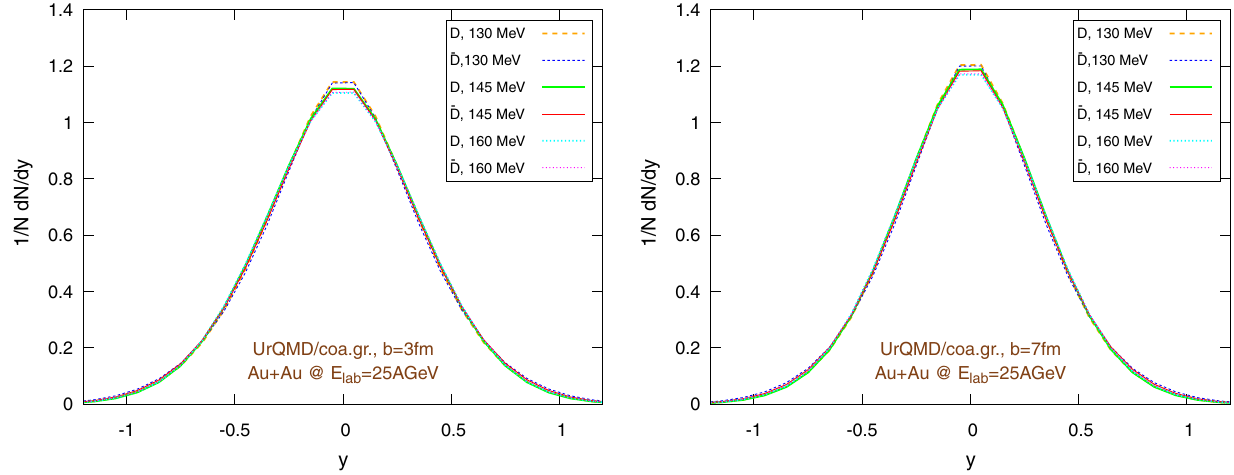
Fig. 13 Final 1 / N d N / d y distribution using the UrQMD/coarse-graining approach for Au+Au collisions at 25 GeV per nucleon in the lab frame, assuming different hadronization temperatures, with fixed parameters: (cid:23) p = 0 . 05 and